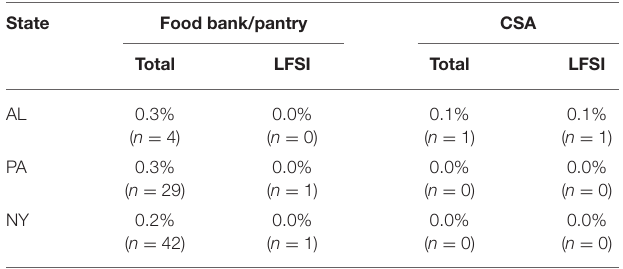
TABLE 4 | Results of thematic analysis of all 2020 food bank, food pantry, and community supported agriculture (CSA) tweets in the state to identify tweets that reference local food system infrastructure